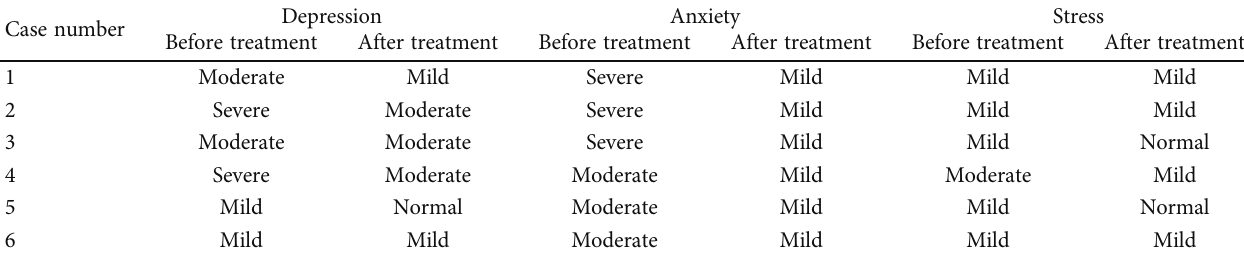
Table 1: DASS test